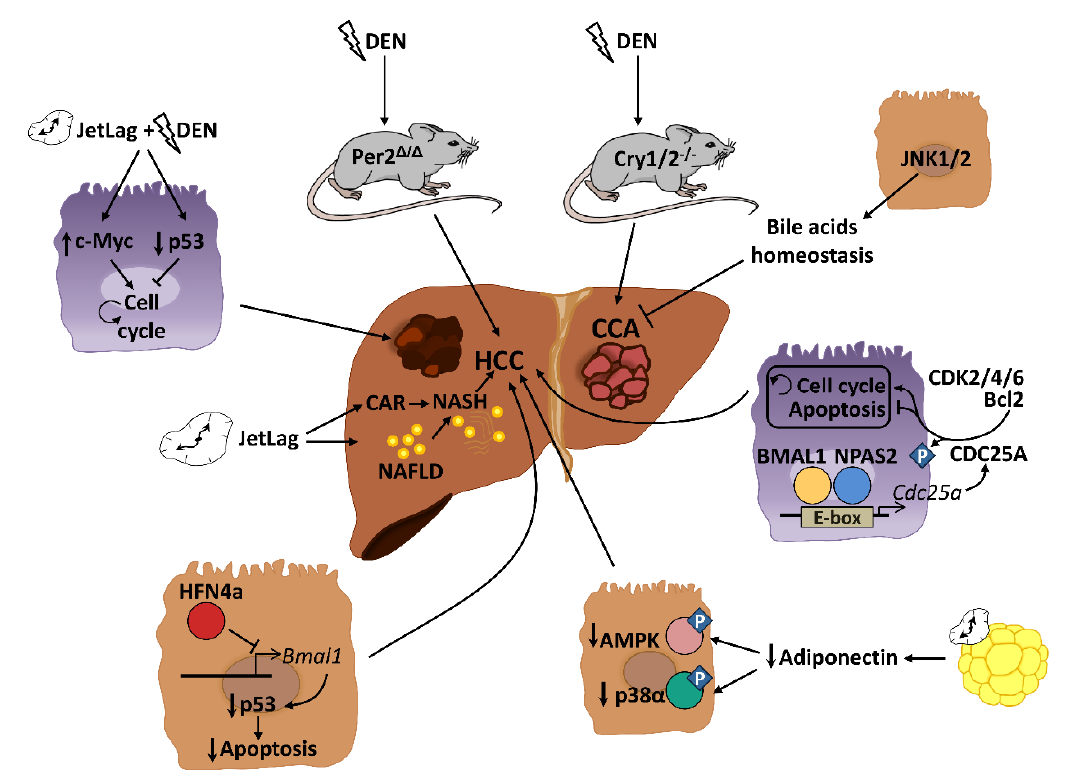
Figure 2. In mice, circadian disruption augments diethylnitrosamine (DEN) induced-hepatocarcinoma (HCC) by upregulating c-Myc and downregulating p53, resulting in activation of the cell cycle. Loss-of-function of Per2 or genetic deletion of Cry1/2 increases the frequency of DEN-induced liver cancer. In contrast, JNK1/2 protects against cholangiocarcinoma (CCA) through the maintenance of bile acid homeostasis. The neuronal PAS domain protein 2 (NPAS2) heterodimerizes with BMAL1 and induces the expression of the phosphatase CDC25A, which dephosphorylates BCL2 and cyclin dependent kinases (CDKs), thereby decreasing apoptosis and activating the cell cycle, respectively, and thus promoting HCC. Low levels of circulating adiponectin promote HCC development through a reduced activation of AMP-activated protein kinase (AMPK) and p38α in hepatocytes. HFN4a inhibits Bmal1 expression and decreases p53 and apoptosis, positively affecting HCC development. Chronic circadian disruption induces non-alcoholic fatty liver disease (NAFLD) and spontaneous hepatocarcinogenesis through the activation of constitutive aldosterone receptor (CAR).